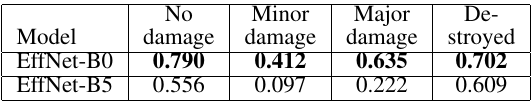
Table 3. Siamese networks results